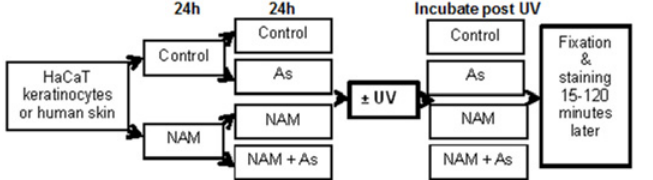
Fig 1. HaCaT human keratinocytes or ex vivo human skin samples were incubated ± 50 μ M nicotinamide (NAM) for 24h, and then incubated ± NAM and ± 2 μ M sodium arsenite (As) for a further 24h. Samples were then irradiated with a single, fixed dose of solar-simulated UV (2J/cm 2 ), before once again being incubated ± NAM and ± As as per their pre-irradiation treatment allocation. The HaCaT cells were allowed to incubate for various periods before fixation; 15, 30, 45 and 75 minutes for oxidative DNA damage and 15, 45, 75 and 120 minutes for cyclobutane pyrimidine dimers. Skin samples were incubated for 45 minutes post-irradiation, when peak levels of DNA photolesions were